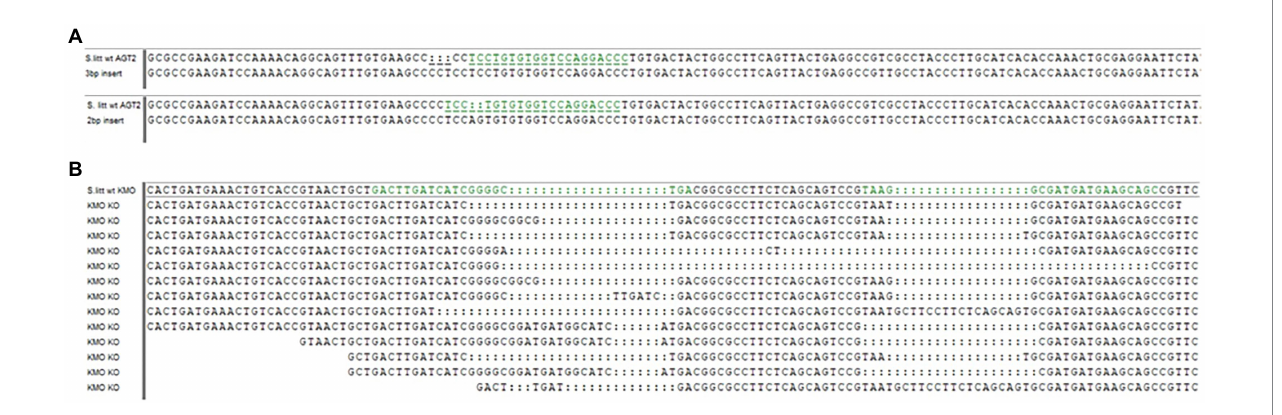
FIGURE 2 Mutated target sequences in AGT2 and KMO genes. (A) 3 bp insert (above) and 2 bp insert (below) occurred in the AGT2 gene compared to the WT allele. The target sequence is highlighted in green in the WT. (B) Examples of KMO-ko alleles compared to the WT allele. The two target sequences are highlighted in green in the